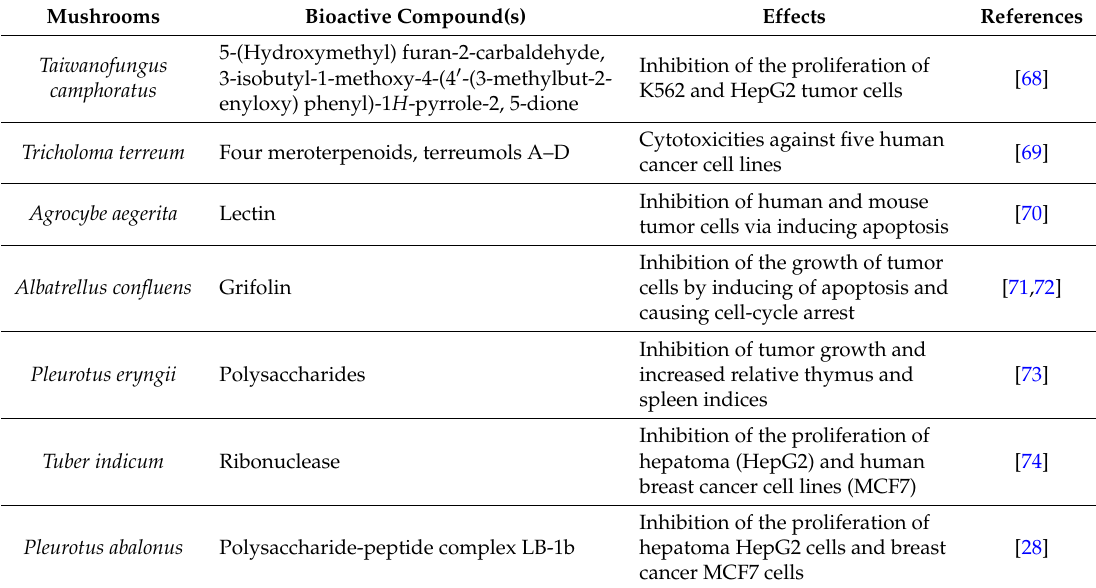
Table 2. Anticancer activities of some